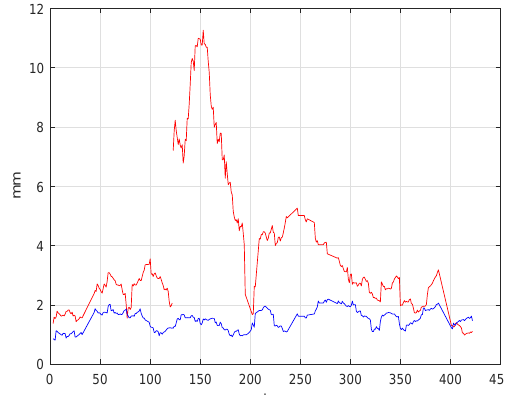
Figure 17. Modelled azimut of the line connecting the West and East points during the observed period